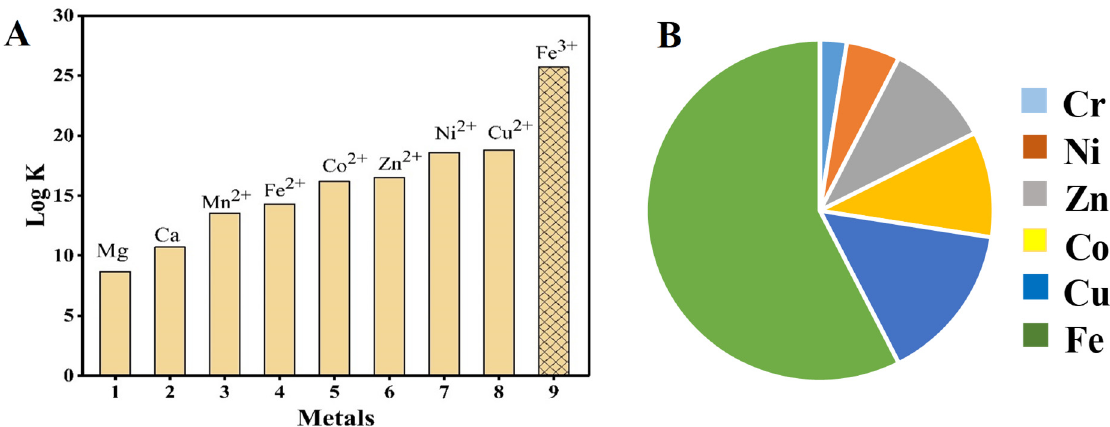
Figure 3. ( A ) Relative stability of Fe-EDTA with other metals, ( B ) relative NO gas and transition metal